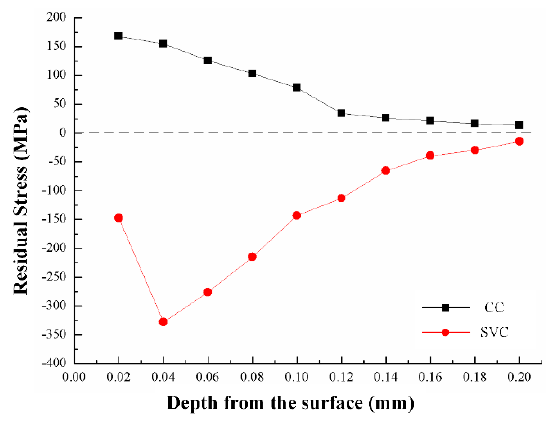
Figure 12. Surface residual stress (cutting speed, 200 m/min; depth of cut, 0.1 mm; and feed rate, 0.005 mm/r).